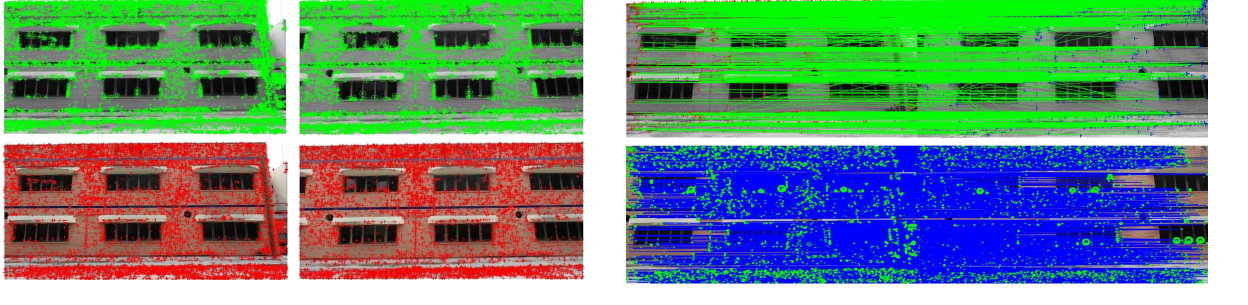
Figure 5. Matched keypoints by SURF (green) and SIFT (blue) operators in 2 nd